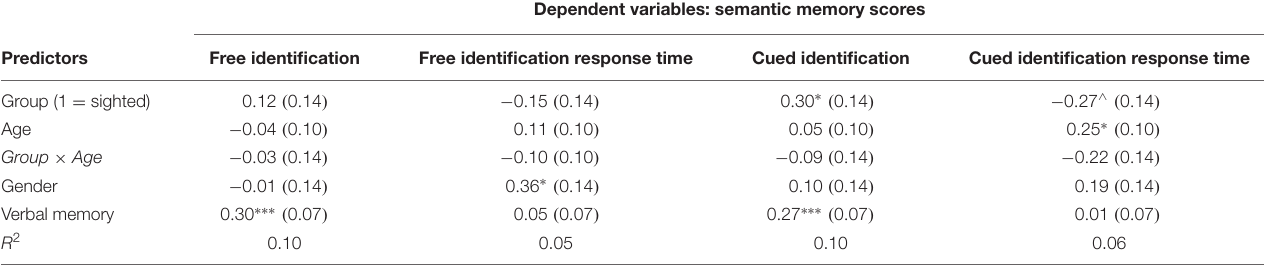
TABLE 3 | A summary of moderated regression models predicting semantic memory